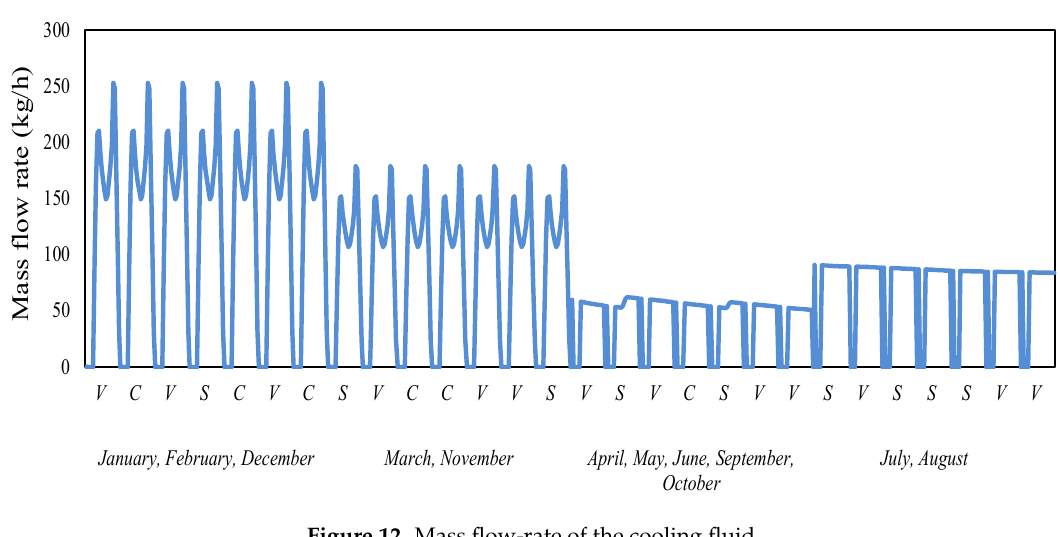
Figure 12. Mass flow-rate of the cooling fluid.